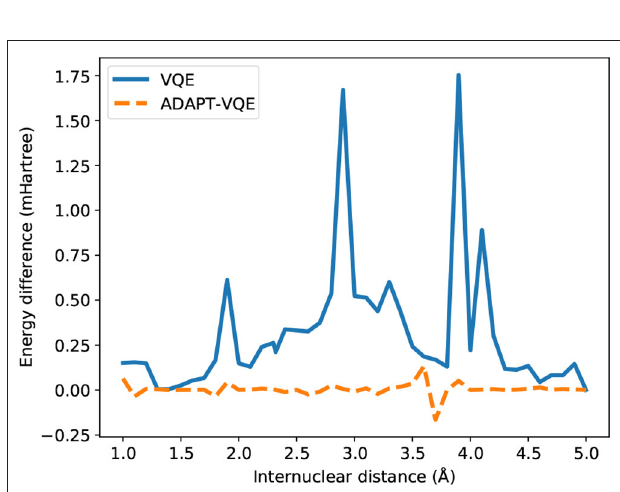
FIGURE 6 | Difference between the energies from COBYLA and L-BFGS optimization with central finite differences for the KH potential energy curve.